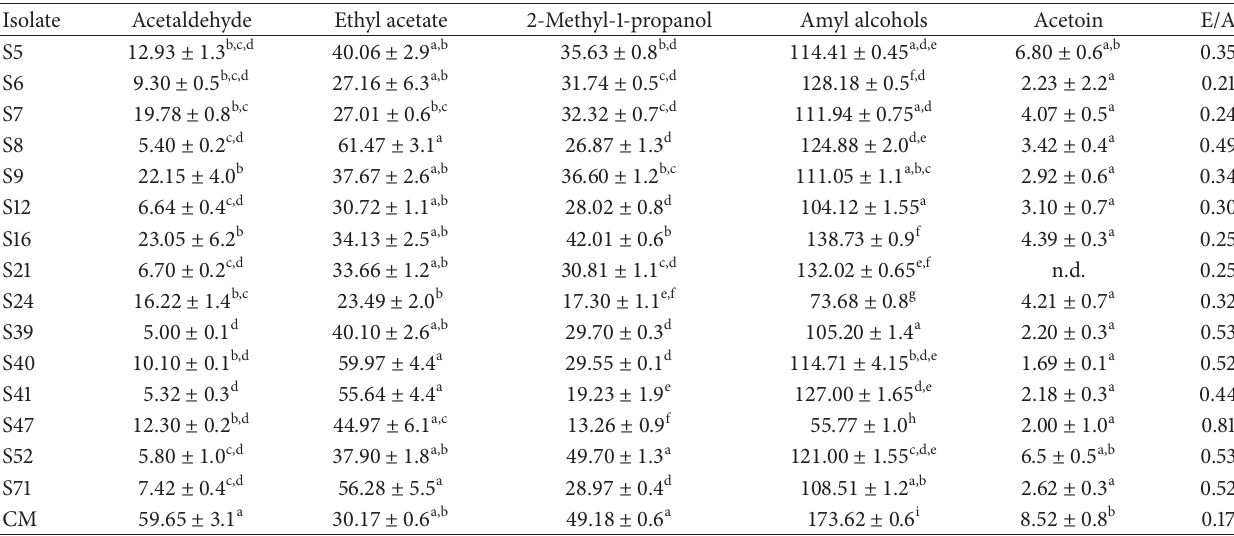
Table 4: Concentration of major volatile compounds in fermented musts obtained with fifteen autochthonous and one commercial (CM) strain of S. cerevisiae